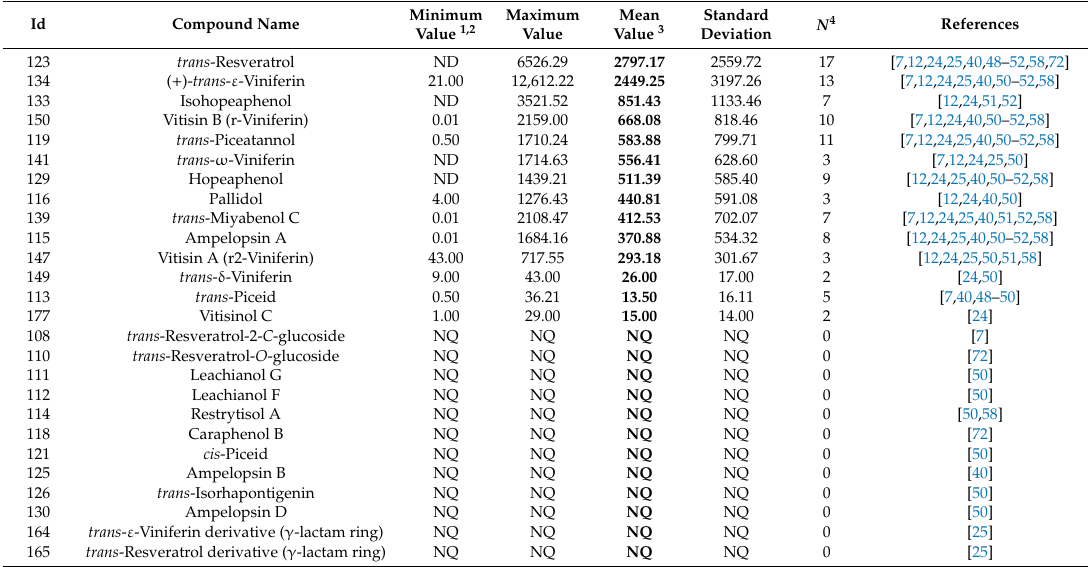
Table 7. Levels (mg / kg) of 26 stilbenic compounds identified in grapevine canes.